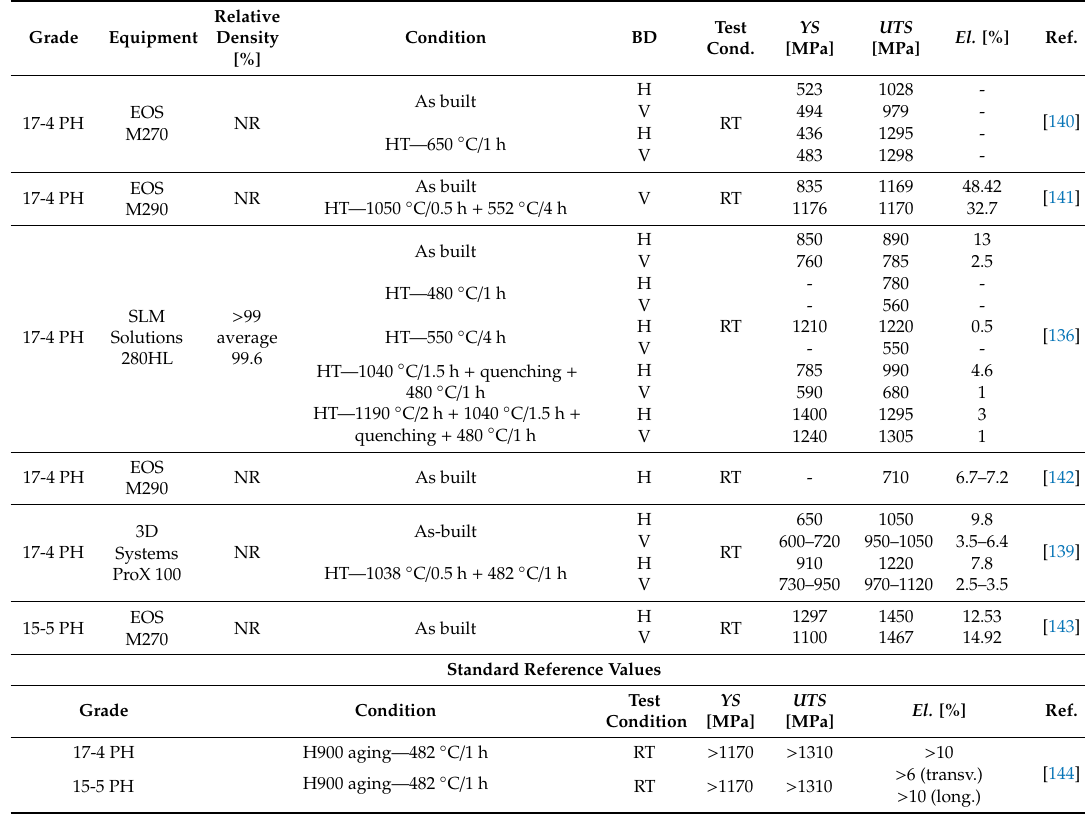
Table 4. Tensile strength of precipitation hardening stainless steel grades obtained from L-PBF, compared to standard reference